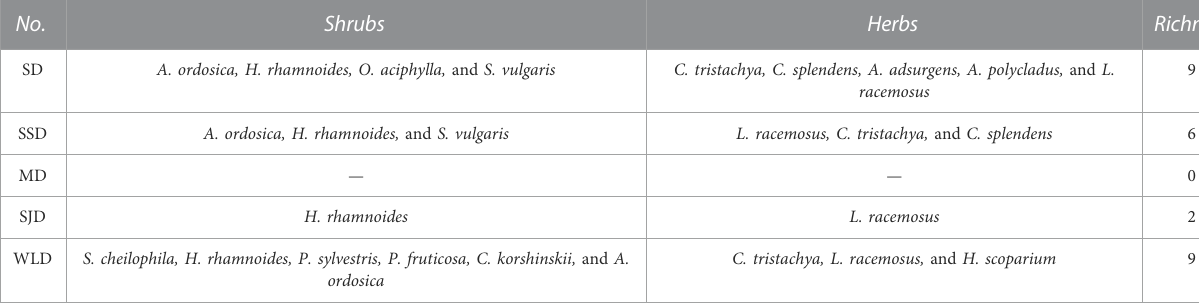
TABLE 3 Species and richness of plant communities on the study sites (2013). No. Shrubs